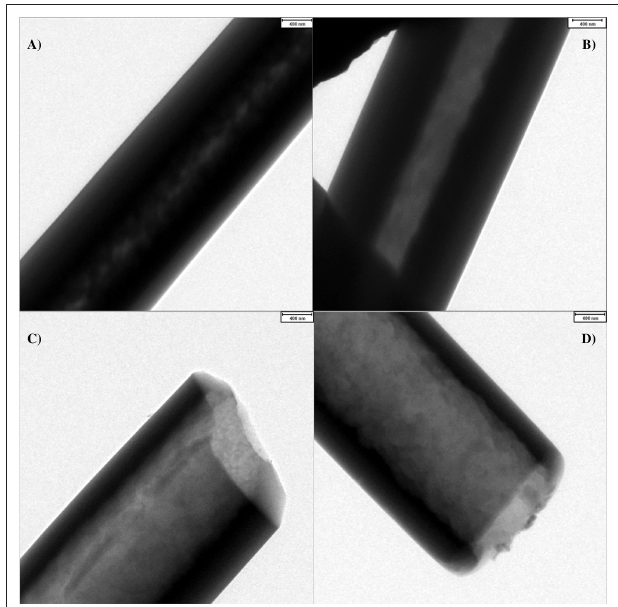
FIGURE 4 | TEM images of carbon fibers obtained from electrospun lignin fibers prepared using an oil flow rate of (A) 0.2 mL/h; (B) 0.4 mL/h; (C) 0.5 mL/h; and (D) 0.6 mL/h. Scale bar: 400